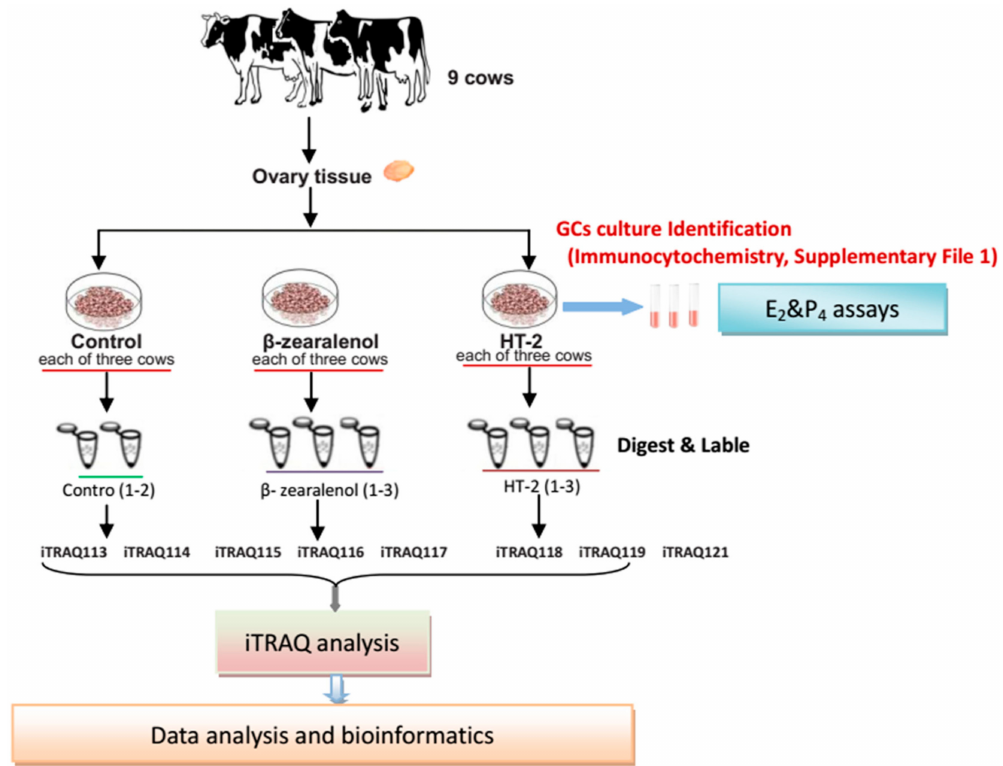
Figure 1. An overview of the experiment. Schematic diagram of the workflow of the isobaric tags for relative and absolute quantification (iTRAQ)-based proteomic experiments. The granulosa cells (GCs) were harvested from nine cows (three cows / group). The cows’ protein samples were pooled for proteomic analyses. For the proteomic assay, the peptides are labelled with di ff erent iTRAQ reagents, which contained the control group (113, 114), β -zearalenol group (115, 116, 117), and HT-2 group (118, 119,